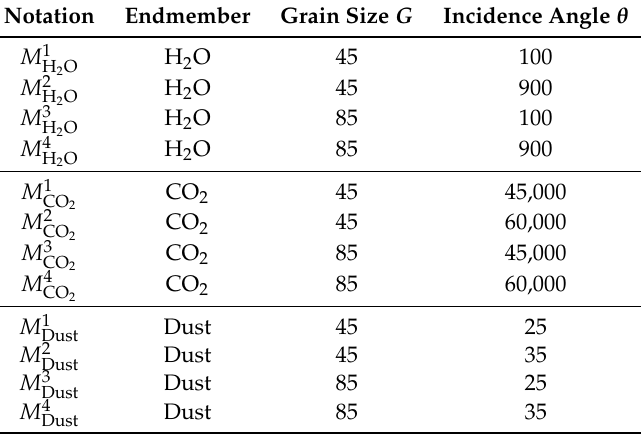
Table 5. Notations of the spectra of the three endmembers with variations caused by different observation geometries and grain sizes.